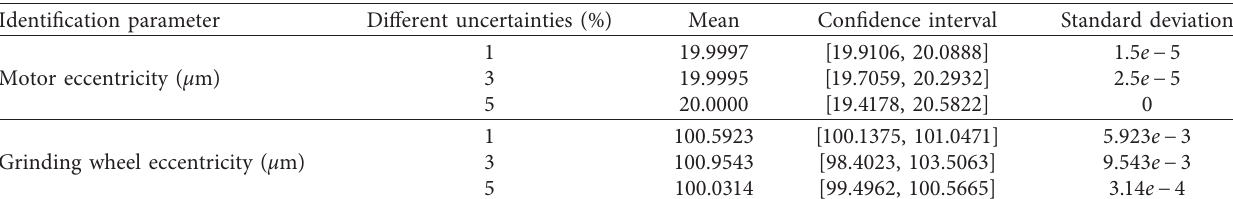
Figure 4: Eccentricity parameter identification iterative Table 3: Parameter identification means and 95% confidence interval. Identification parameter